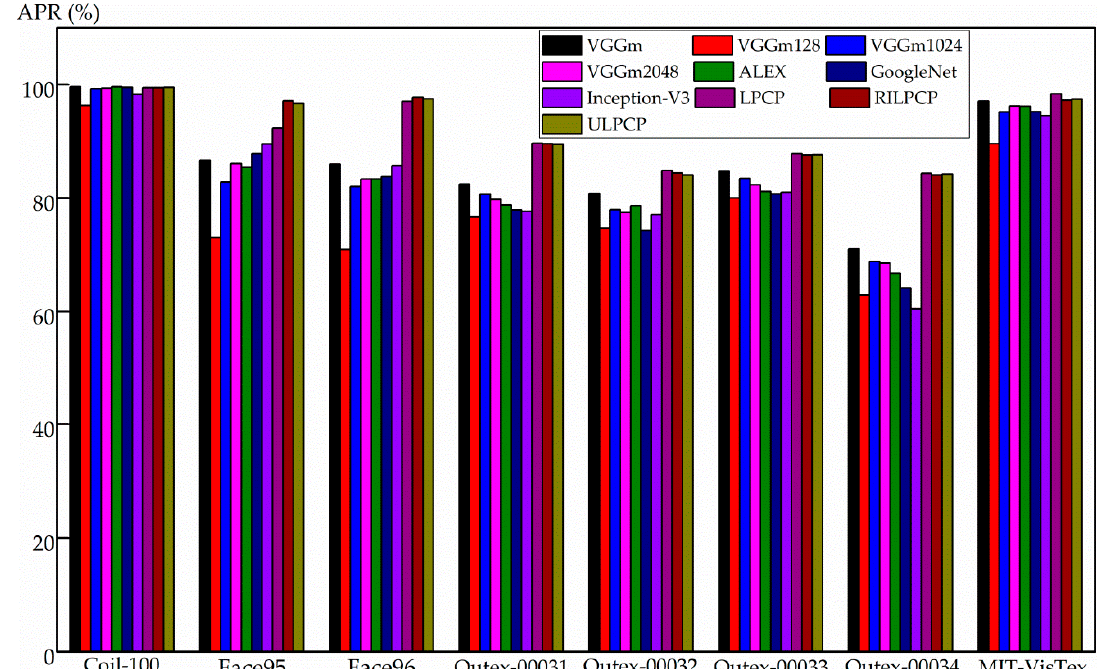
Figure 8. The average precision rate (APR) comparisons among the proposed descriptors and the CNN-based descriptors on the eight CNN-based descriptors on the eight databases.